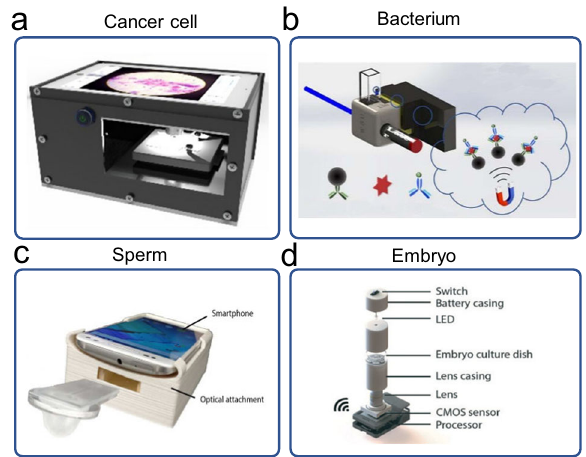
Fig. 9 | Detection of cells on mHealth platforms. a Cancer cell detection. The fi gure illustrates the design of a comparison study on the early detection of potentially malignant oral lesions by conventional cytology, tele-cytology, and ANN-based diagnoses ( fi gure adapted with permission from Sunny et al. 37 ). b Bacterium detection. The fi gure illustrates a portable smartphone-based device with a sandwich immunosensor for E. coli O157:H7 detection ( fi gure adapted with permission from Zeinhom et al. 125 ). c Sperm detection. The fi gure shows an image of the smartphone accessory and micro fl uidic chip for sperm detection ( fi gure adapted with permission from Kanakasabapathy et al. 126 ). d Embryo assessment. The fi gure shows an exploded image of the stand-alone optical system and its various components. The system is wirelessly controlled using a smartphone to photograph embryos on a standard embryo culture dish. CMOS denotes com- plementary metal oxide semiconductor ( fi gure adapted with permission from Kanakasabapathy et al. 127